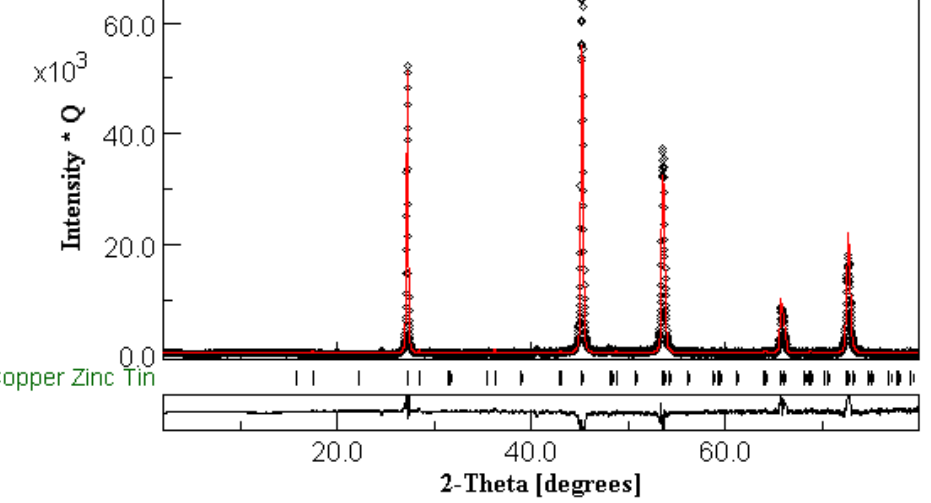
Figure 2. An example of Rietveld Refinement of the XRD data obtained for Cu 2 ZnSn 0.8 Si 0.2 Se 4 , which was performed with the MAUD software (version 2018). Bragg’s R-factors were Rb = 8.804 and Rwp = 13.754.